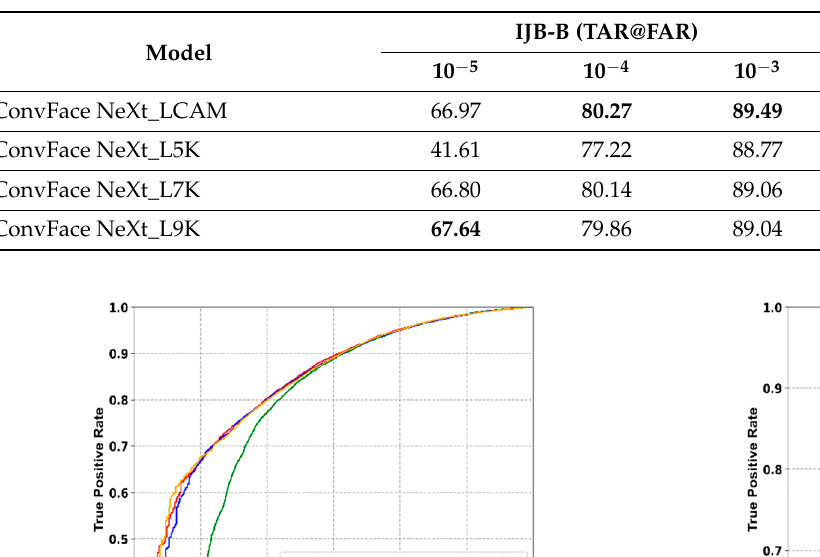
Table 2. Verification accuracy of different kernel sizes for IJB-B and IJB-C datasets. (Bold values are Table 2. Veri fi cation accuracy of di ff erent kernel sizes for IJB-B and IJB-C datasets. (Bold values are the highest obtained values by the methods.) the highest obtained values by the methods).